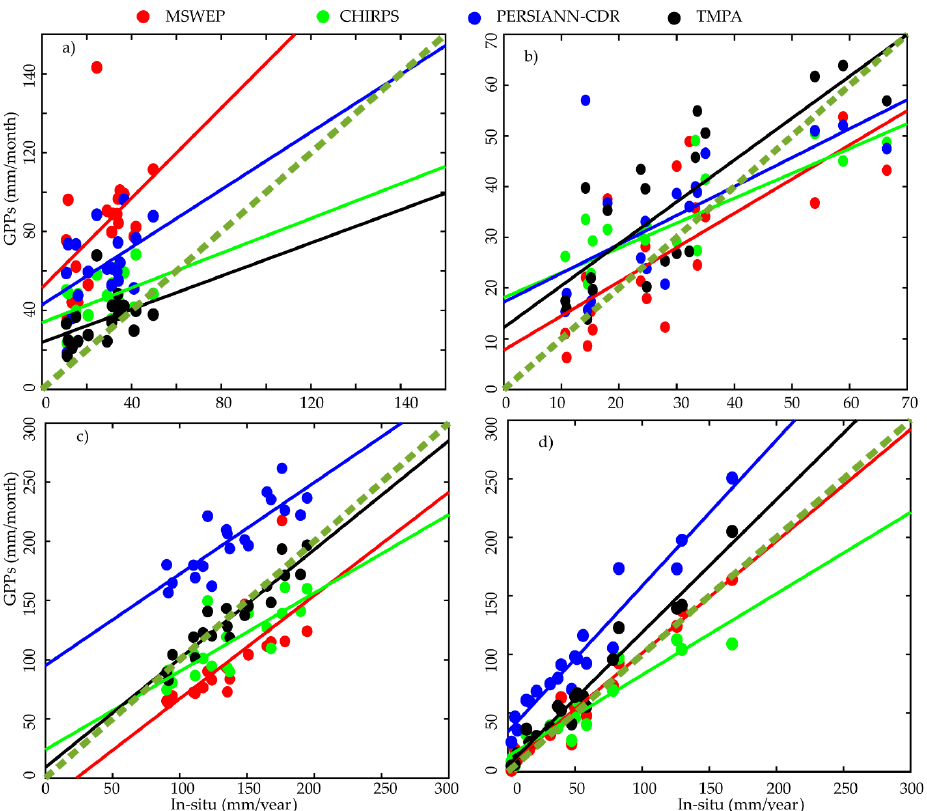
Figure 10. Interannual variability of pre — monsoon ( a – b ) and monsoonal precipitation ( c – d ) in selected regions for in-situ and GPPs. ( a – d ) are equivalent to regions 1, 2, 3 and 4 in Table 1. Table 4. Descriptive statistics of the interannual precipitation variability in selected regions. Regions 1 and 3 experience pre—monsoon precipitation, while regions 2 and 4 experience monsoonal precipitation.